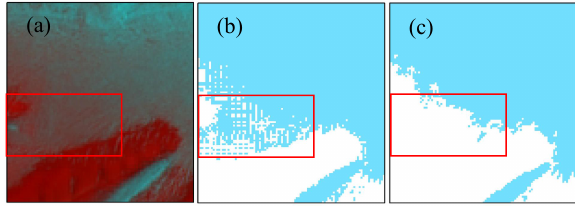
Figure 11 . Snow cover extraction results in thin snow cover areas: (a) Sentinel-2 false color image; (b) dynamic threshold